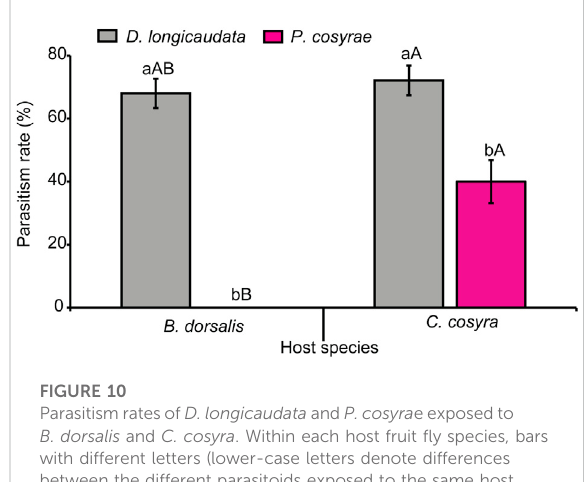
FIGURE 10 Parasitism ratesof D. longicaudata and P. cosyra eexposed to B. dorsalis and C. cosyra . Within each host fruit fl y species, bars with different letters (lower-case letters denote differences between the different parasitoids exposed to the same host while upper case letters denote differences between the different host species exposed to the same parasitoid species) are statistically different (Tukey tests: p ≤ 0.05, n = 400). Error bars indicate